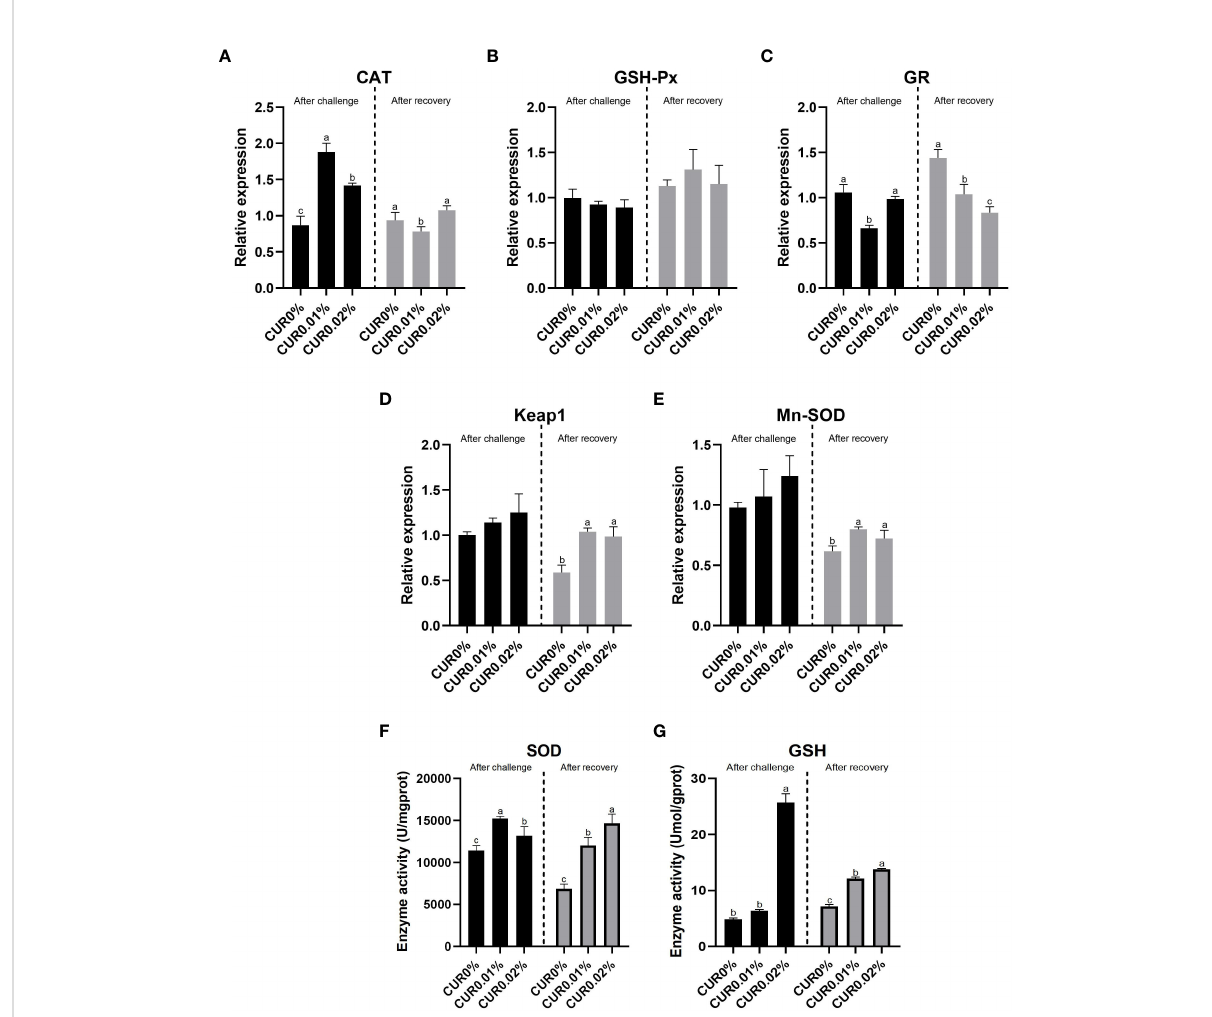
FIGURE 5 The relative expression of CAT (A) , GSH-Px (B) , GR (C) Keapl (D) Mn-SOD (E) gene and the enzyme activity of SOD (F) , GSH (G) in spleen tissue of the greater amberjack subjected to ammonia challenge experiment and recovery experiment. Different letters above bars indicate signi fi cant differences at the 0.05 level. Data are expressed as the means ± SD